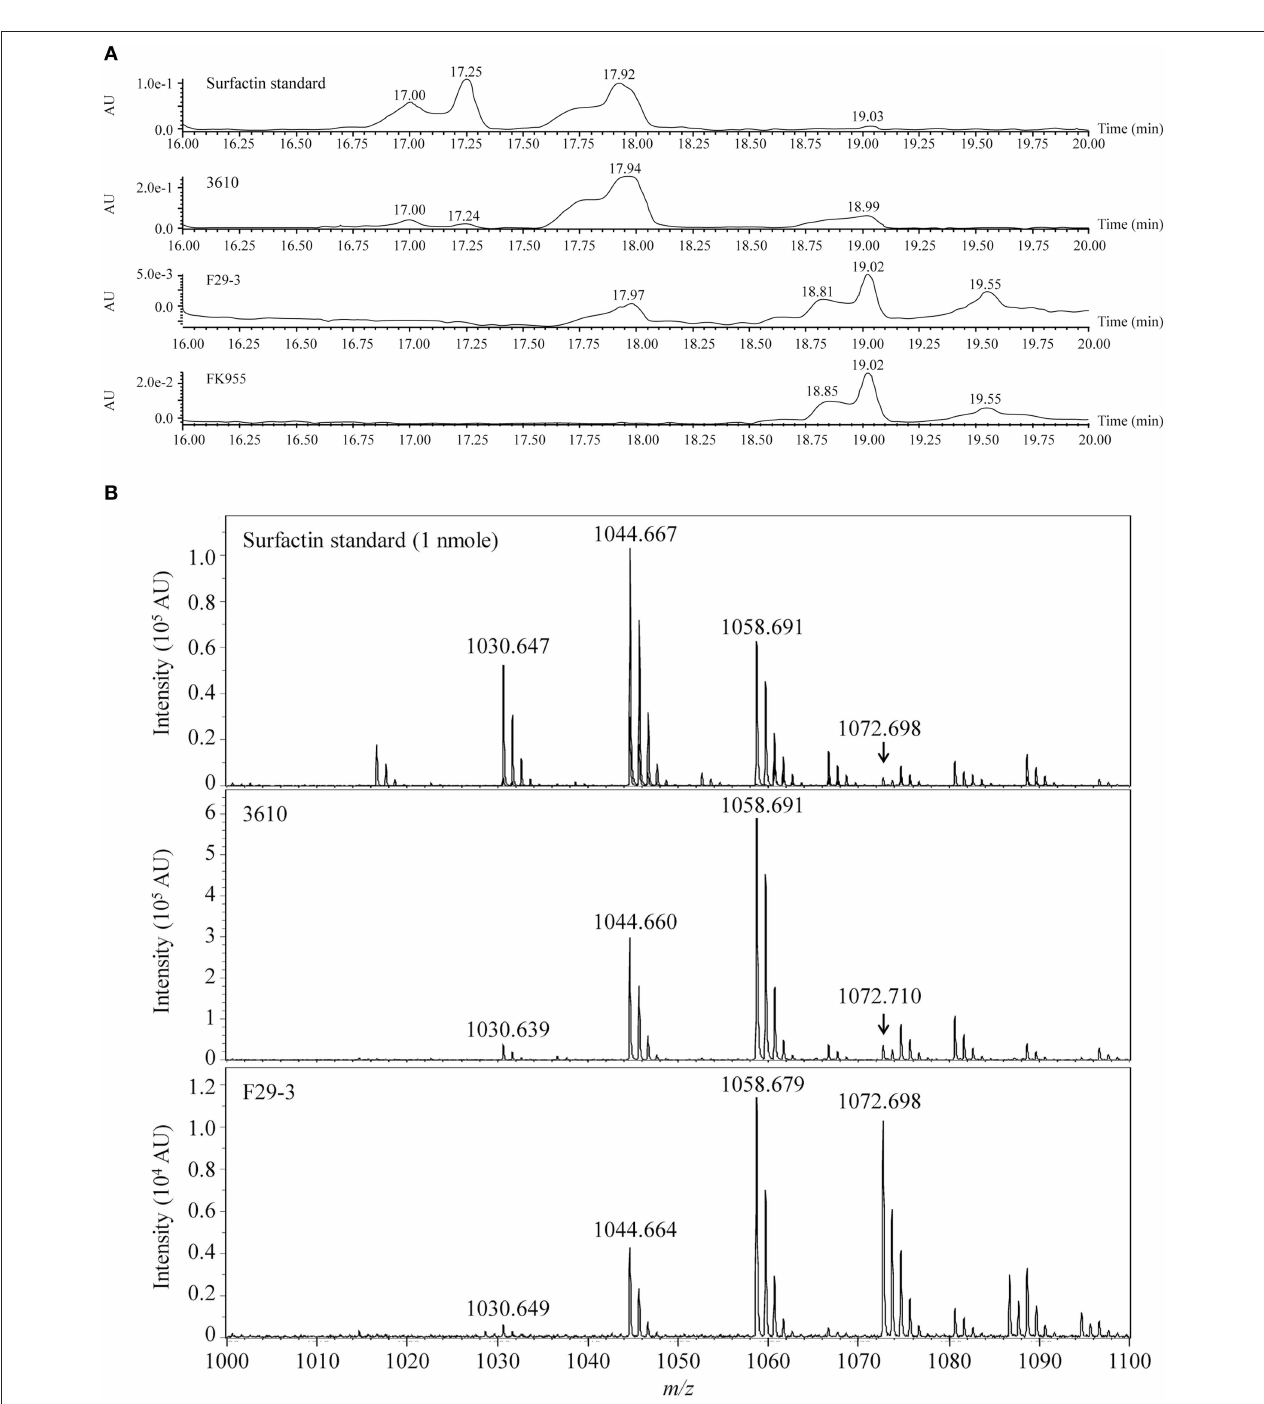
FIGURE 2 | LC-MS of surfactin purified from strains 3610, F29-3, and FK955. (A) Strain 3610 was cultured in 50-ml LB broth; strains F29-3 and FK995 were cultured in 1 liter LB broth for 16h. Surfactin in the culture supernatants was purified and analyzed by HPLC. Pure surfactin was used as a standard. (B) The HPLC peaks with retention times of 17.94 (strain 3610) and 17.97 (strain F29-3) were analyzed by MALDI-TOF mass spectrometry. The peaks with m/z 1030, 1044, 1058, and 1072, which correspond to the mass of [M + Na] + ions of surfactin isoforms, are indicated. AU, Absorbance